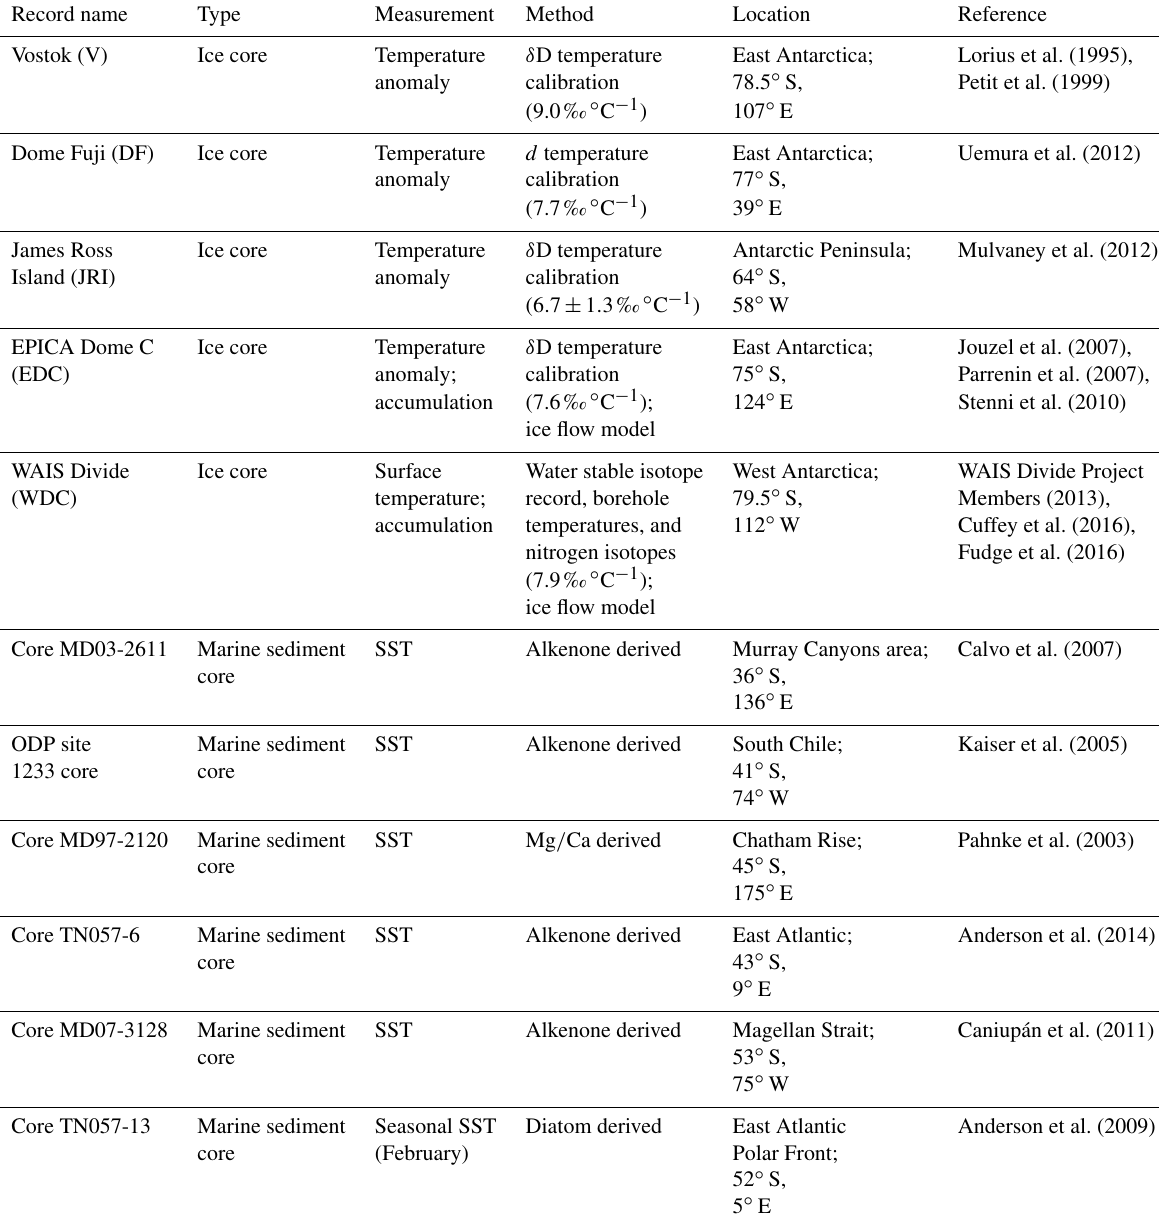
Table 2. Antarctic and Southern Ocean proxy record